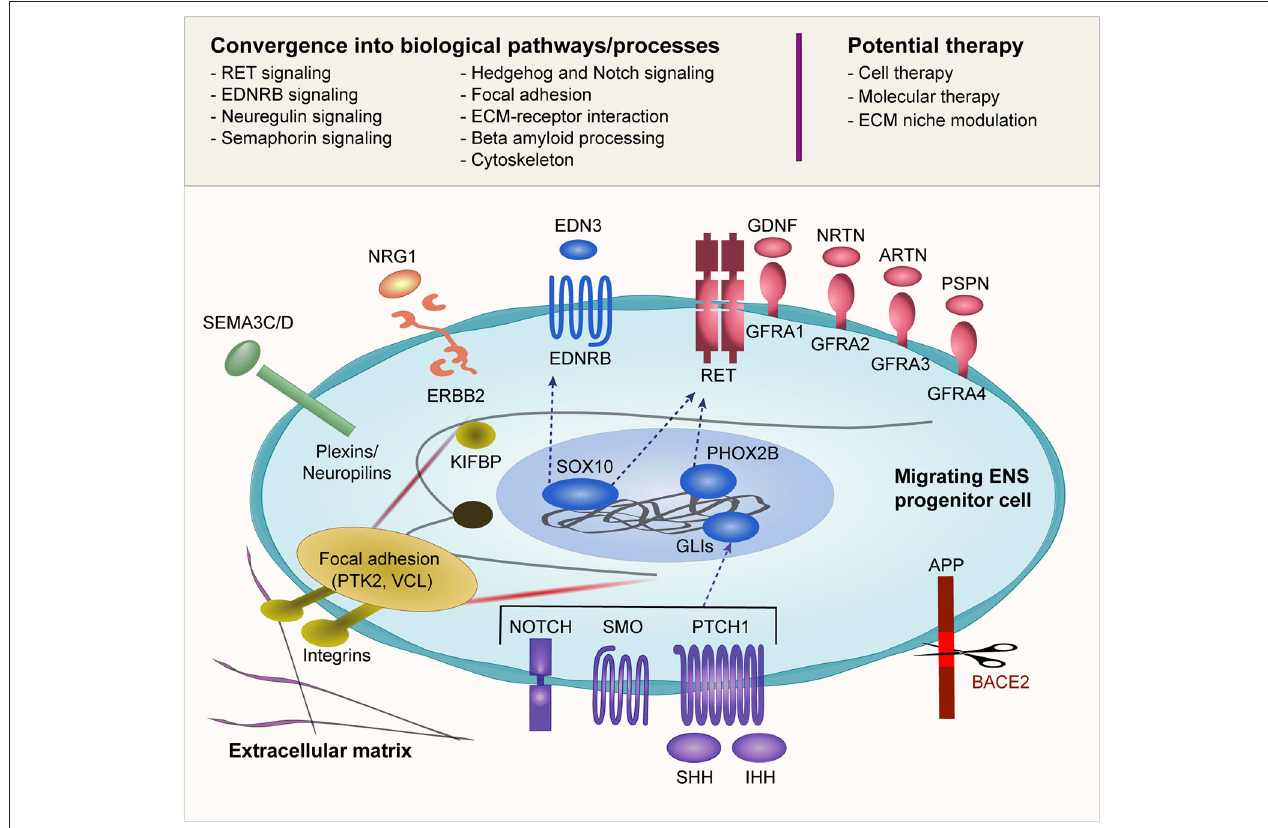
FIGURE 2 | Biological pathways implicated in HSCR. Many of the reported HSCR-associated genes converge into several biological pathways as shown in this figure. The schematic diagram illustrates an ENCC migrating through the gut and its interaction with the surrounding environment including the ECM. The ENCC receives cues from the surrounding environment through different signaling molecules that regulate the cellular machinery as well as feedback interaction with the surrounding niche. The potential therapeutic approaches that are currently under investigation are also shown.